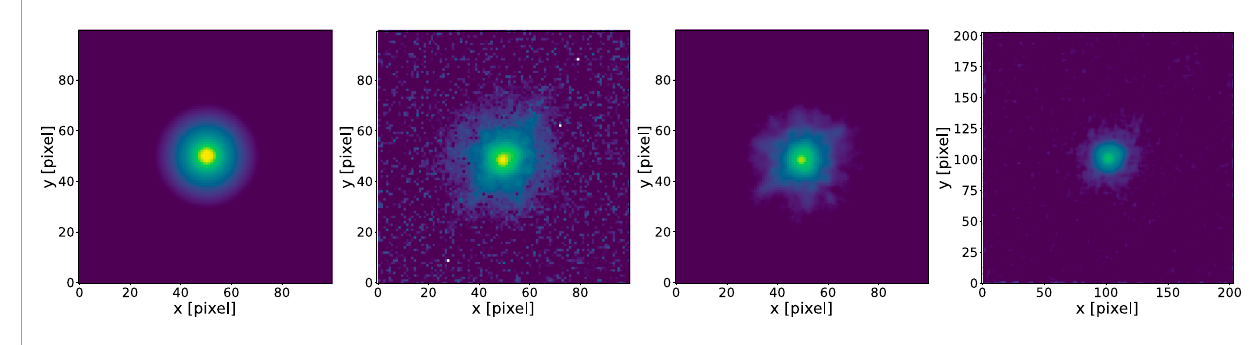
FIGURE 2 The panels show a comparison among the PSF images obtained with the methods described in Section 2.2 . They refer to those of the Abell S1063 cluster in the F814W waveband from the LT23 analysis. From left to right, the panels show the “Moffat PSF”, the “Observed PSF”, the “PCA PSF” and the “Effective PSF”. The first three PSF images are 100×100 pixels wide, while the “Effective PSF” is 200×200 pixels since the minimum oversampling factor of the ‘Effective PSF’ relative to the input stars along each axis is 2 (see PHOTUTILS manual for a detailed explanation).